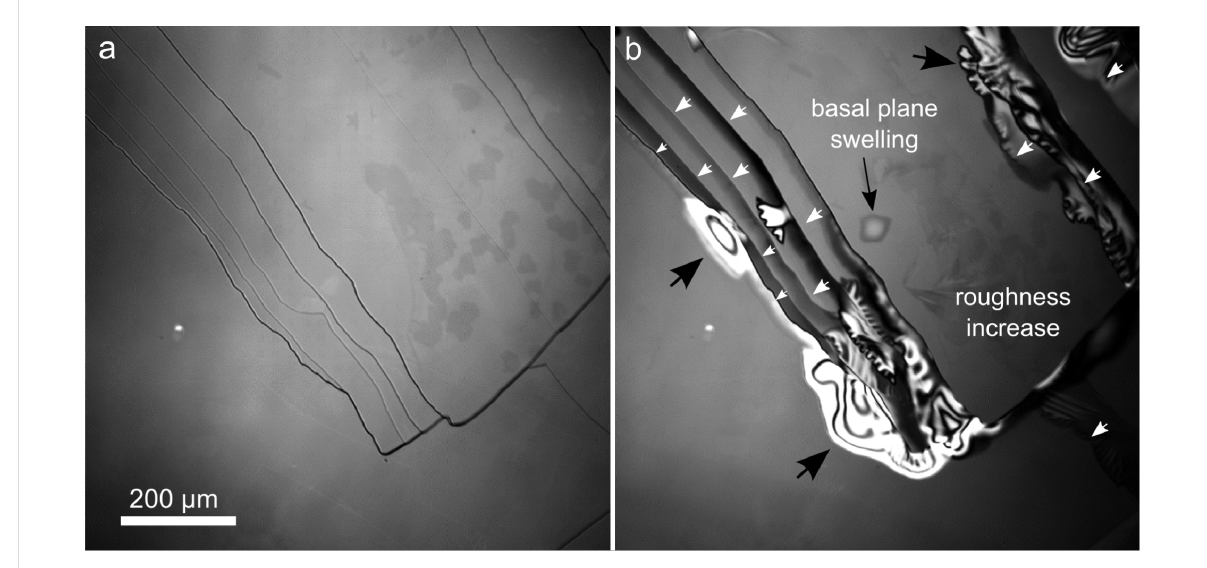
Figure 1: LCM-DIM images of a) freshly cleaved biotite (001) surface and b) the same surface after about 17 h of reaction at pH 1 and 25.0 °C. Upper layers appear in some areas “overexposed” (white zones) owing to layer breaking and curling (peeling process) after swelling. Black arrows indicate areas with layer swelling and peeling, and white arrows indicate the dissolution direction (see text).